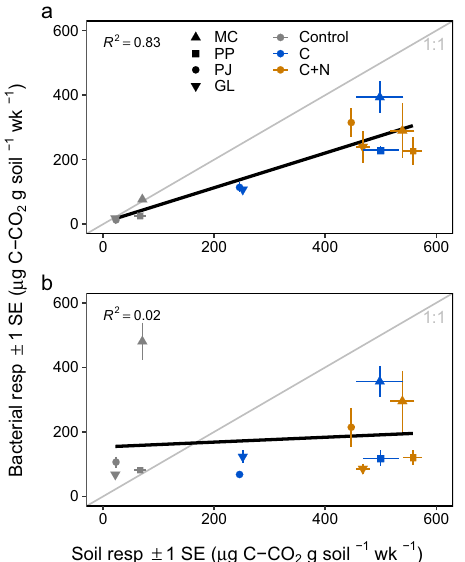
Fig. 1 Fit of modeled respiration scaled from taxon-speci fi c isotopic enrichment against community soil respiration, by mass of carbon (C) per g dry soil per week (wk). a Bacterial respiration is estimated as the sum of modeled taxon-speci fi c respiration and plotted against measured soil respiration. b Bacterial respiration is estimated from the community- level enrichment of all 16S copies present in a sample (per g dry soil). Points show mean respiration values ± standard error (SE) across replicates ( n = 3 experimental replicates) for each ecosystem (symbol MC mixed conifer forest, PP ponderosa pine forest, PJ piñon pine-juniper scrubland, GL desert grassland) and treatment (color control = no amendment, C = glucose, C + N = glucose and [NH 4 ] 2 SO 4